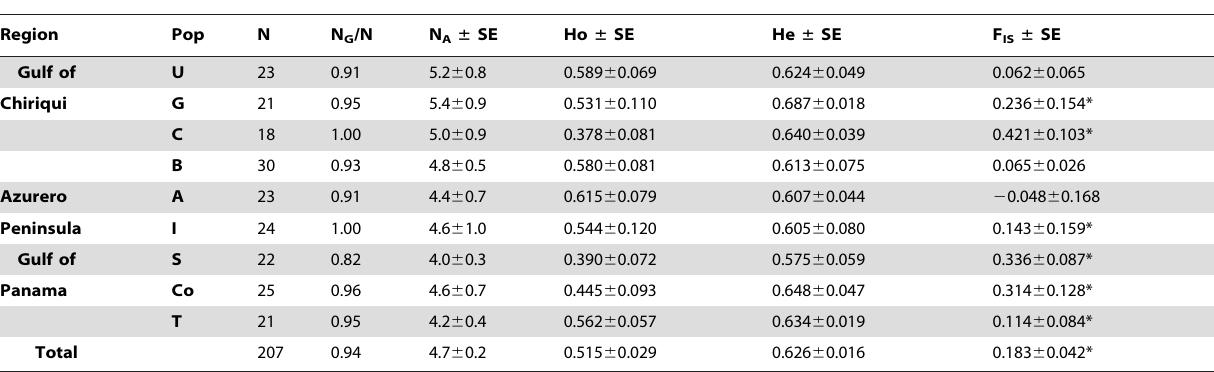
Table 2. Population genetic indices for the nine populations.